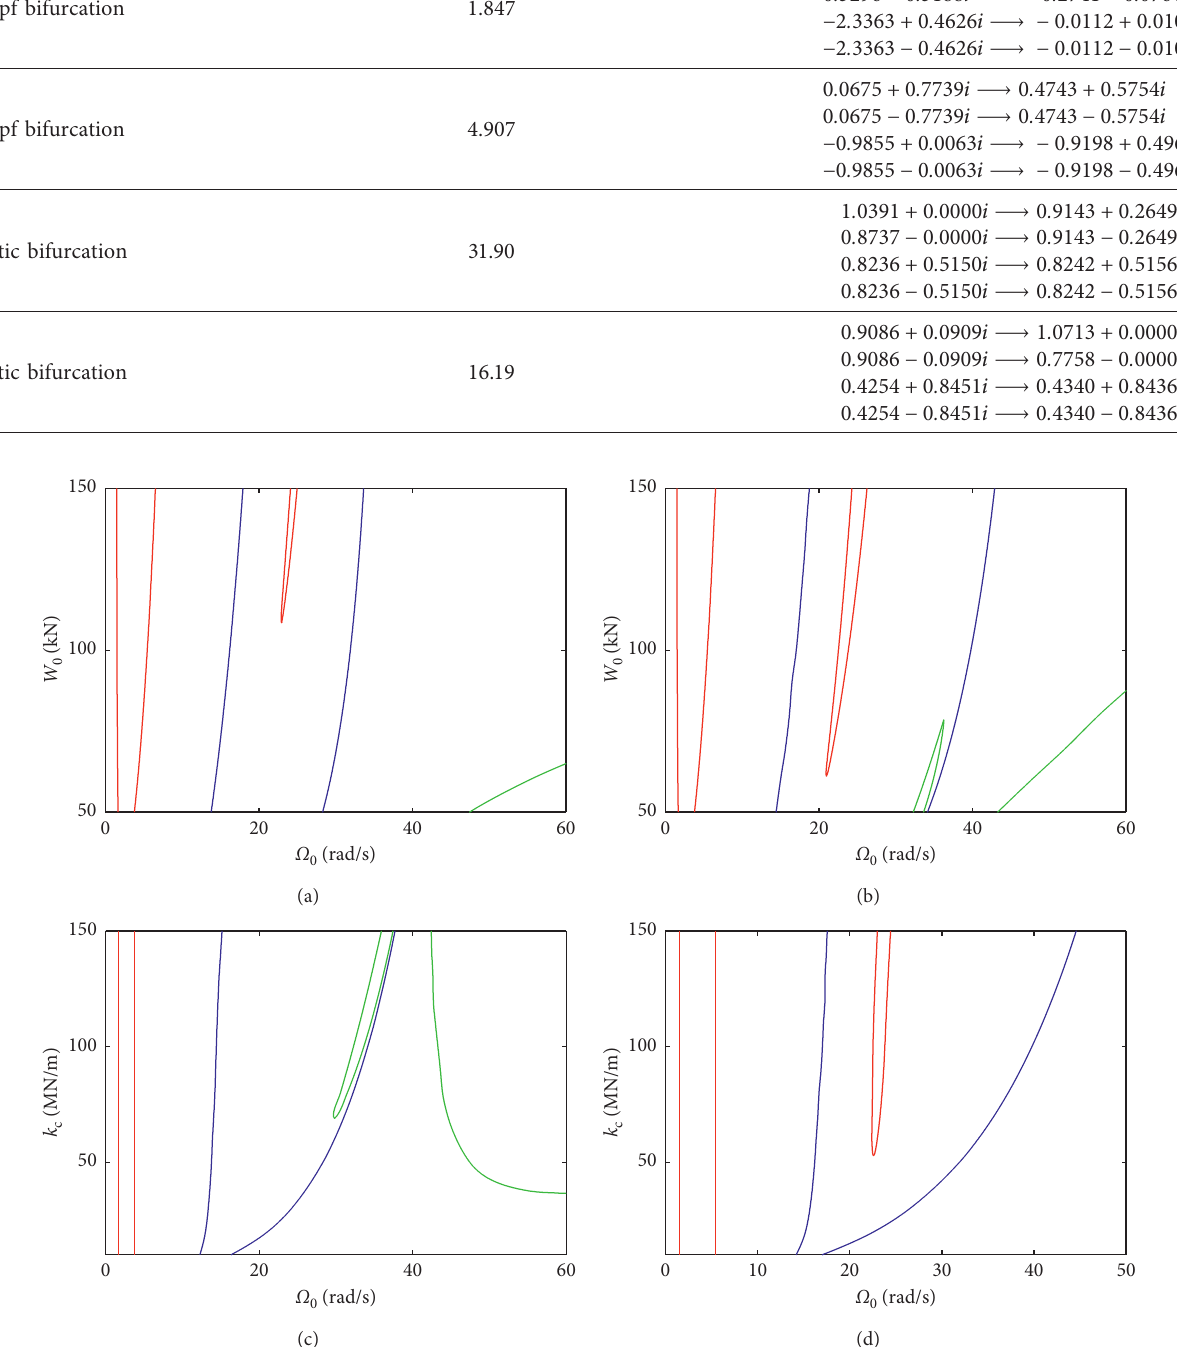
Figure 5: Bifurcation boundary curves in different parameter planes: (a) k � W 0